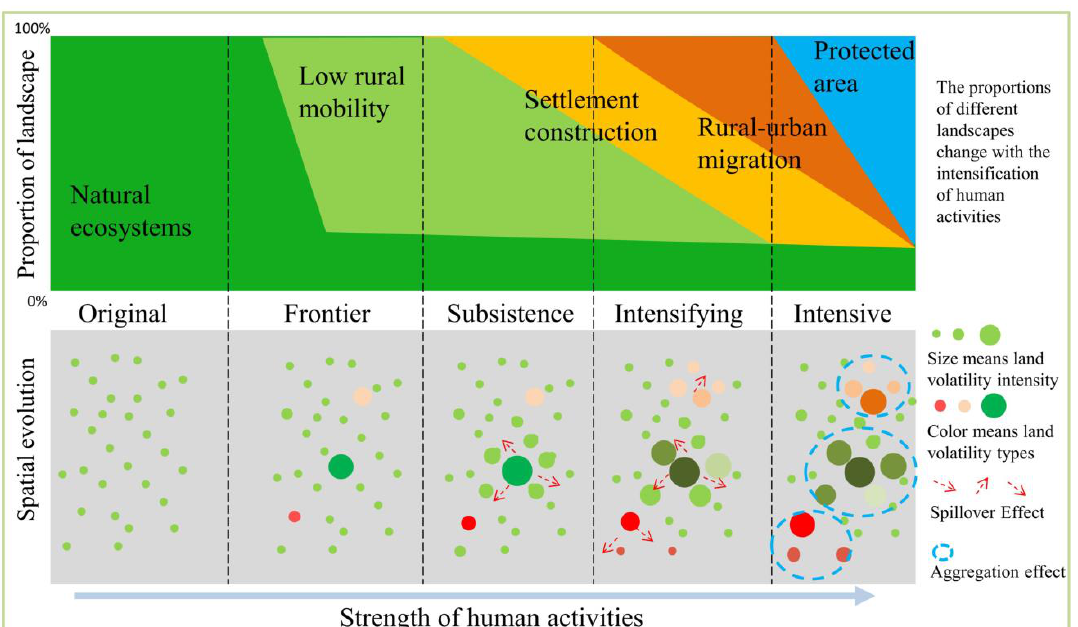
Figure 10. Process of land use volatility in a regional area. The part above shows the different proportions of different land use intensities over time. The part below shows the gradual spillover effect after land use volatility caused by human activities, which can lead to an agglomeration ef- fect in time and